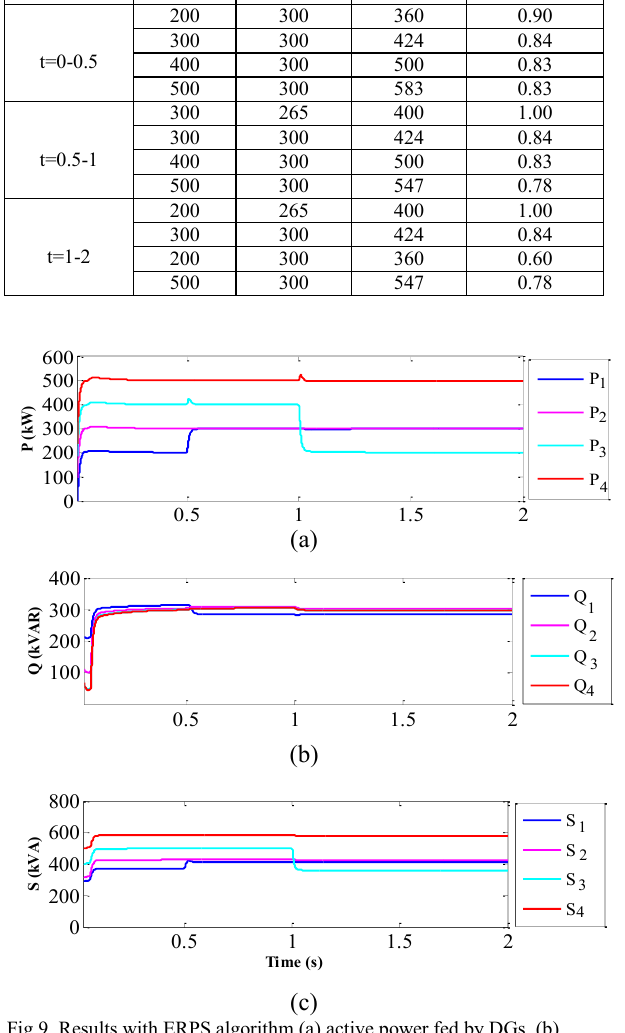
Fig.9. Results with ERPS algorithm (a) active power fed by DGs, (b) reactive power shared by the inverters, (c)apparent power of each inverter